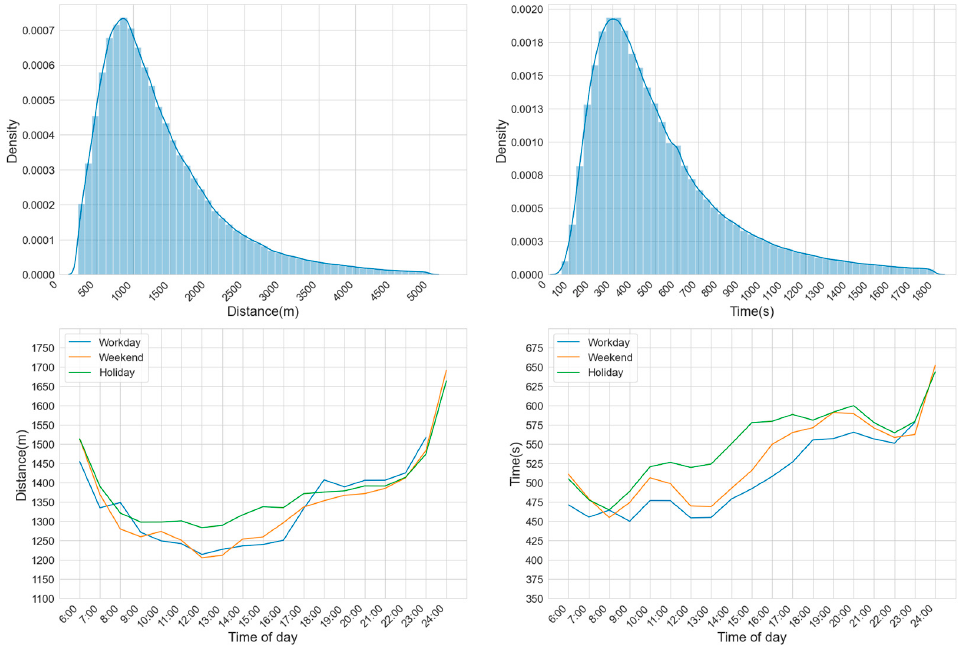
Figure 5. Distribution of cycling distance, cycling time kernel density, and time variation for DBsMIC. 2.